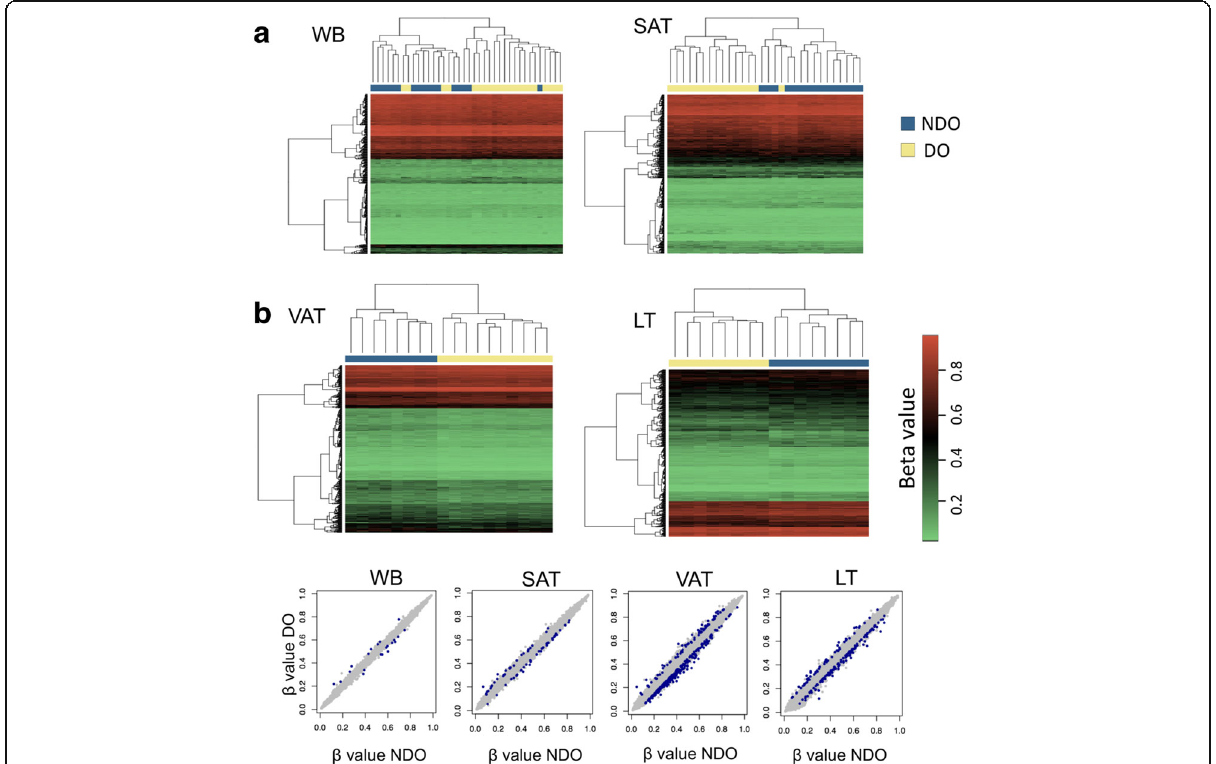
Fig. 1 Differential methylation profiles from individuals with obesity and T2D. ( a ) Heat map shows the top 500 differentially methylated CpG sites. Hierarchical clustering distinguishes NDO (blue bar) from DO samples (yellow bar). ( b ) Scatter plot of DNA methylation shows the average beta values of NDO and DO patients. DMCs are highlighted in